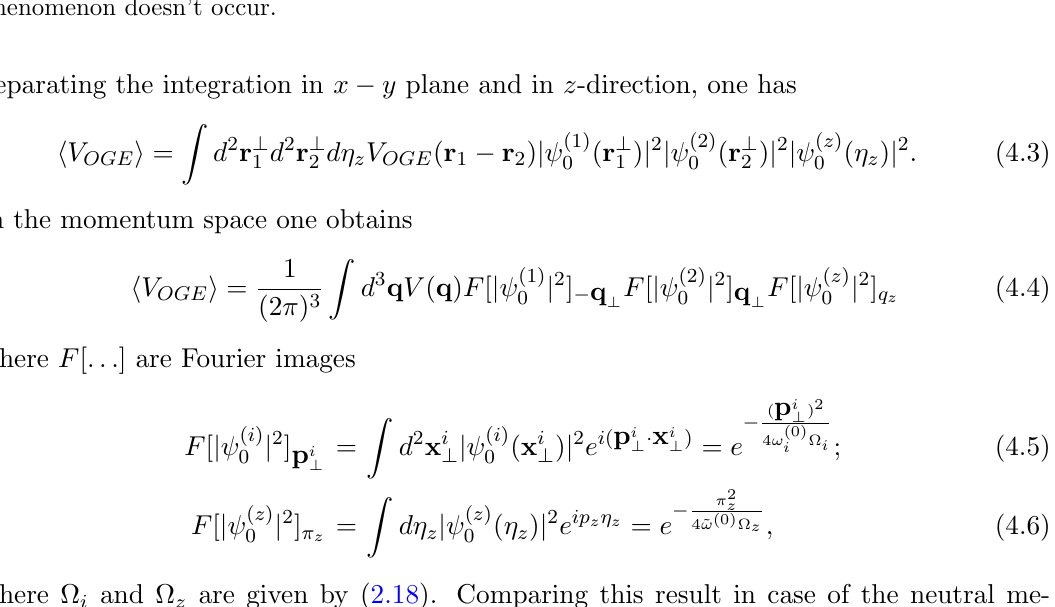
Figure 1 . Color Coulomb matrix element h V OGE i (in GeV) in MF with screening (solid line) and without screening (dashed line) by q (cid:22) q pairs. h V OGE i saturates at eB ! 1 and the fall-to-the-center phenomenon doesn’t